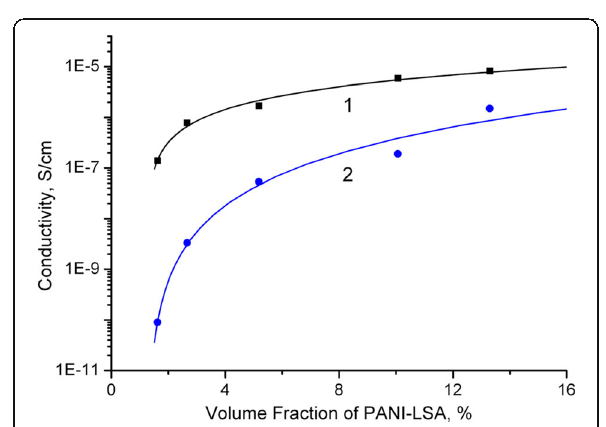
Fig. 5 Dependencies of DC conductivity of the cast ( 1 ) and compression molded ( 2 ) PS/PANI-LSA nanocomposite films on the volume fraction of